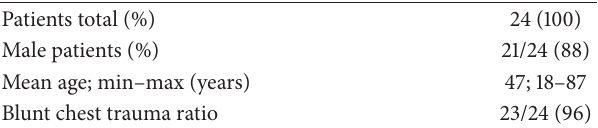
Figure 1: PneumoScan device. Table 1: Patient